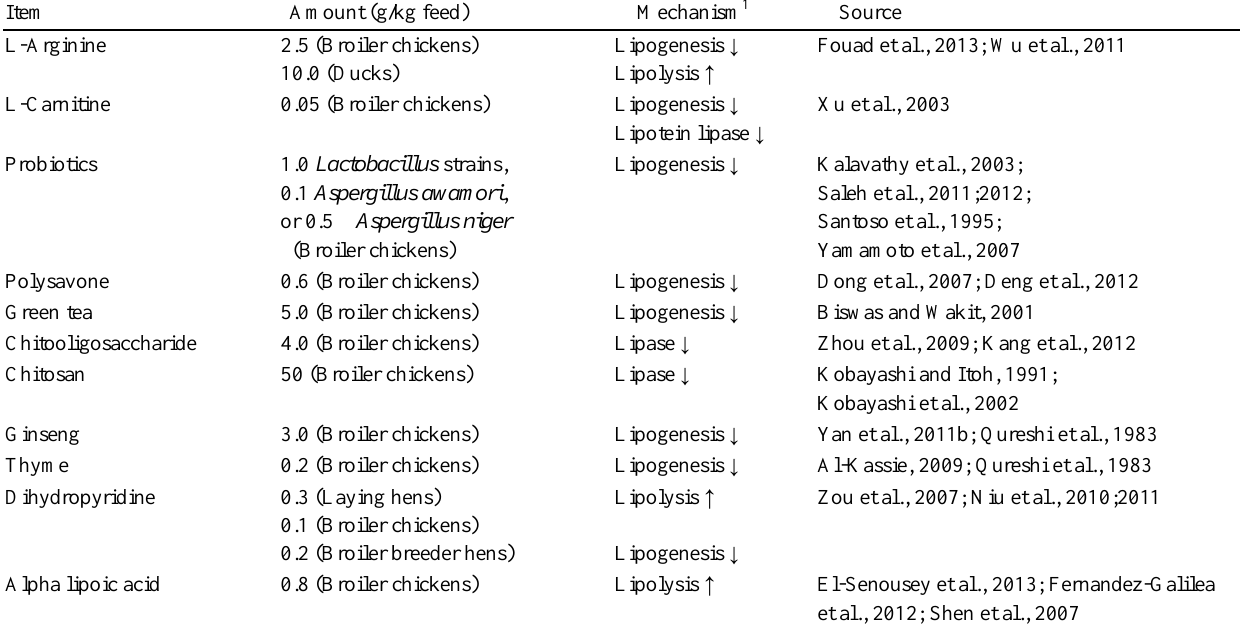
Table 1. Some additives used in poultry diets to reduce the abdominal fat content